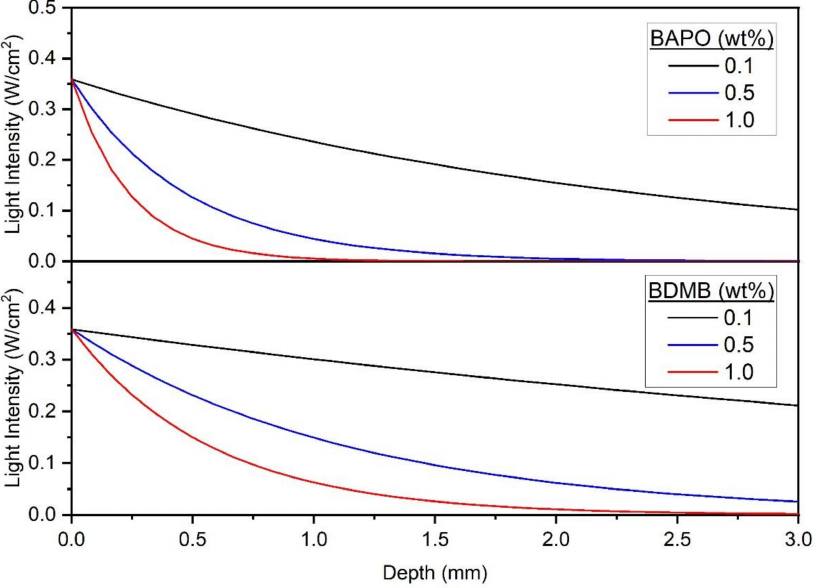
Figure 13. Predicted transmitted-light intensity at t = 0 across the 3.0 mm polymer depth, at 398 nm wavelength and an incident-light intensity of 380 mW/cm 2